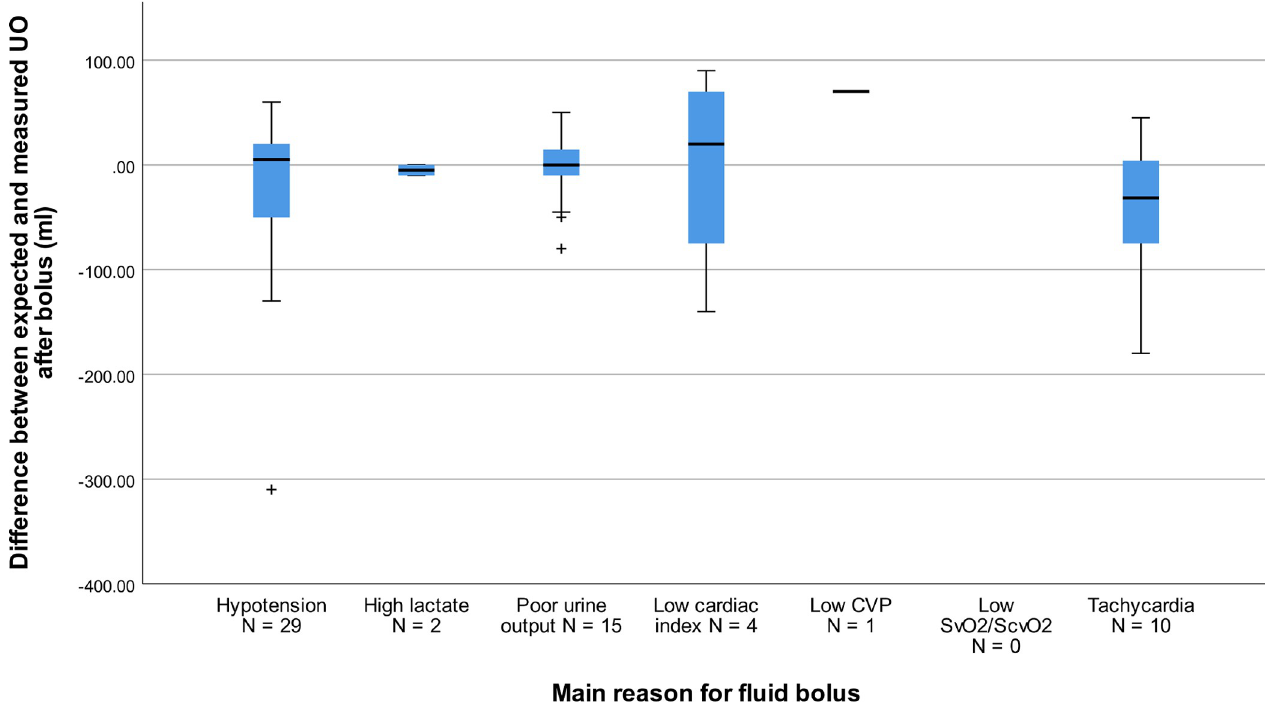
Fig 5. Boxplot of difference between measured and expected UO by indication for bolus. Boxplot showing difference between expected and measured MAP by main reason for administration of fluid bolus. Positive values indicate a higher value for expected UO compared to measured, and the inverse for negative values. UO = Urine output. CVP = Central venous pressure. ScvO2 = Central venous oxygen saturation. ScvO2 = Mixed venous saturation.